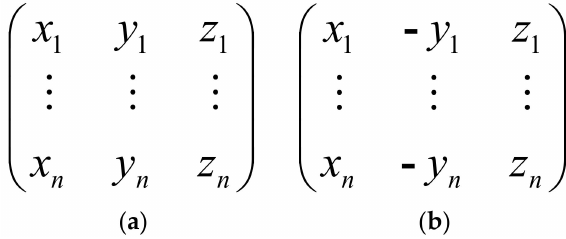
Figure 7. Robot motion track array. ( a ) Running track array; ( b ) return track